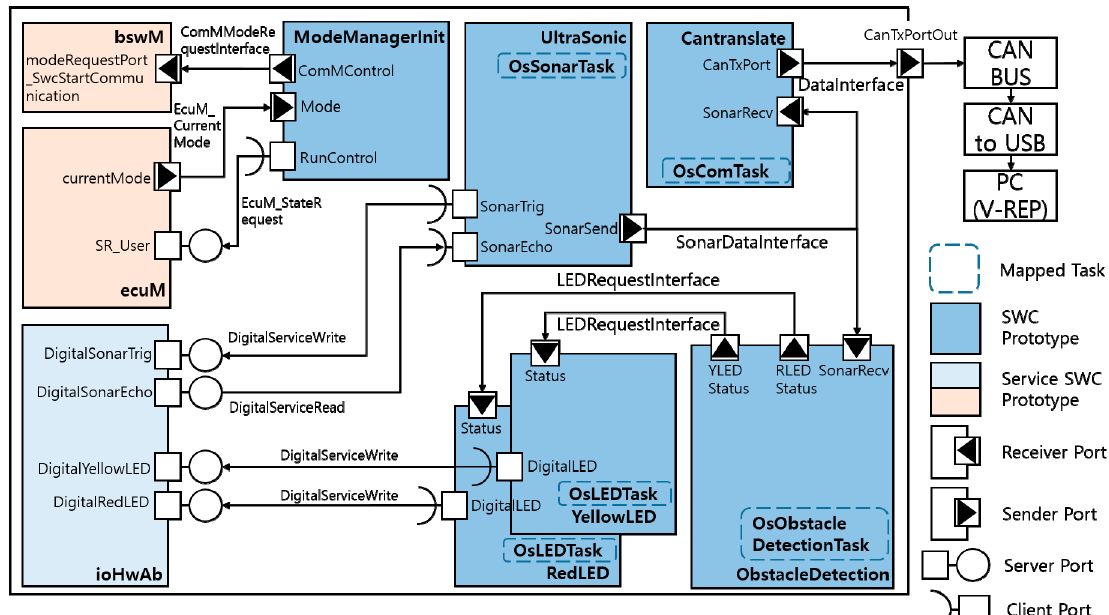
Figure 4. Collision warning application layer overview.